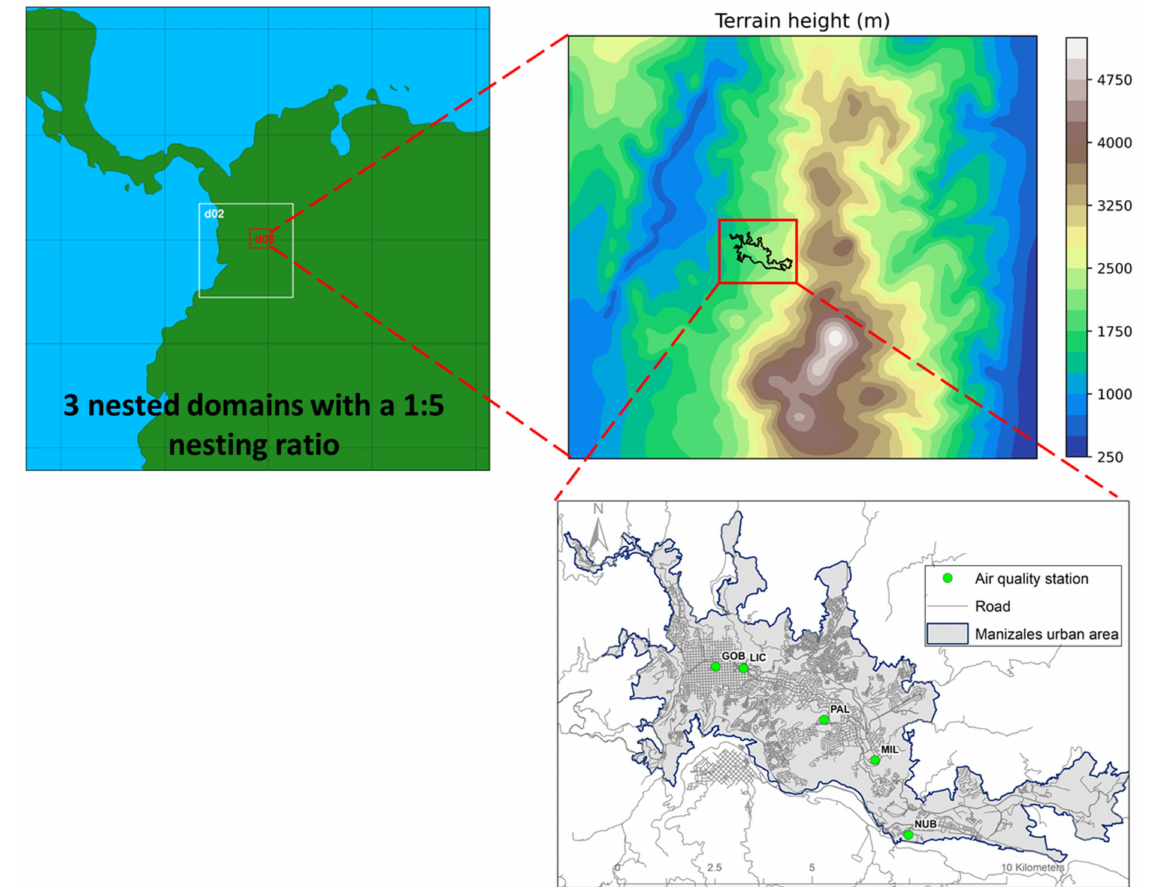
Figure 2. Emission inventory domain ( bottom-right ) and configuration of model simulation with three domains ( up-left ). The zoom map is shown for the fine-grid domain D3 ( top-right ). The urban area of Manizales city ( bottom-right ) includes the location of monitoring stations used for model